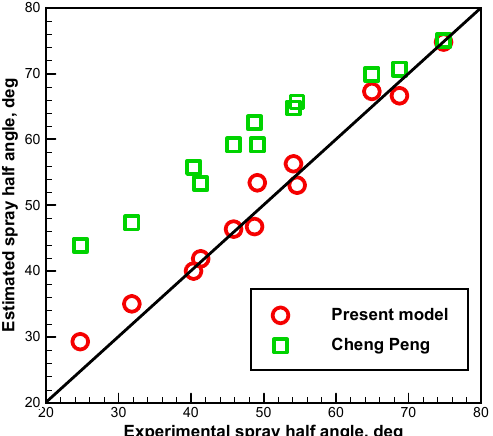
Figure 9. Comparison of the measured and estimated spray half angles.